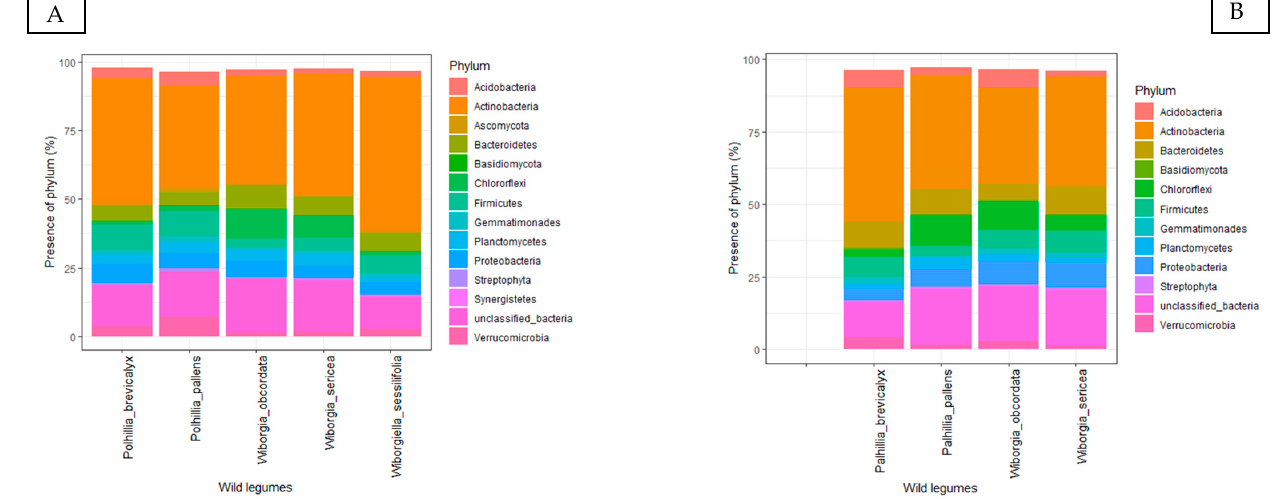
Figure 2. Taxonomic distribution based on 16S rRNA sequences described at phylum level in rhizosphere soils sampled during the ( A ) dry and ( B ) wet seasons.